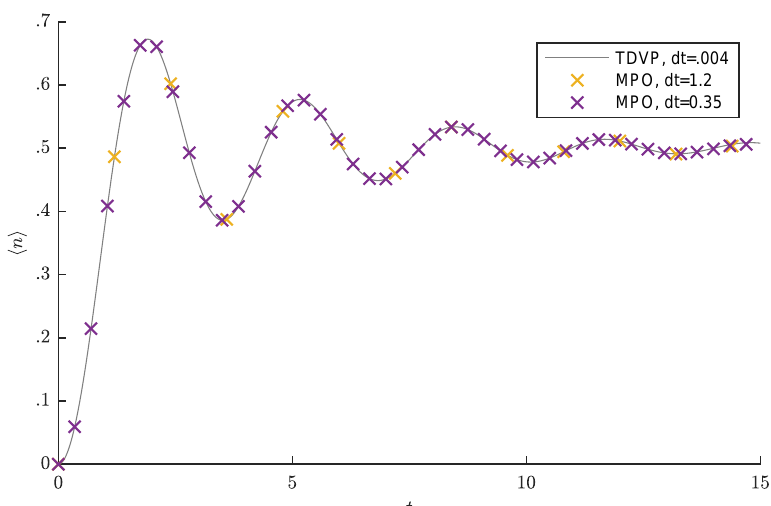
Figure 2: Time evolution of the staggered magnetization relative to its initial maximal value, as measured by ( (cid:49) + Z ) / 2 on one of the sites, for the Néel state evolved with the XXZ Hamiltonian with ∆ = 1 / 2. We show results for different time steps for the MPO cluster expansion from Ref. [ 16 ] . The gray line is a reference result obtained with TDVP with very small time step. We have made explicit use of the U ( 1 ) symmetry, and fixed the total bond dimension to χ =